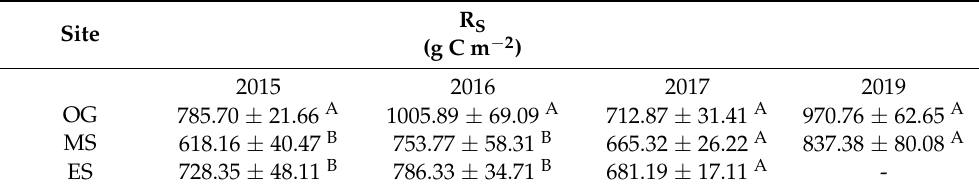
Table 4. Annual C emission from R S along a forest succession in tropical dry forest in northwestern Mexico. Data are presented as mean ± standard error. Capital letters denote significant differences among sites ( p < 0.05).